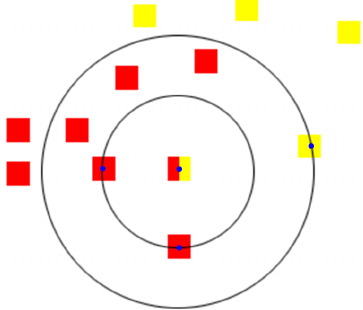
Figure 1. A sample graph of sub-pixel in a mixed pixel and its near- est pure pixel(s) of the same land cover type. There are two land cover types: yellow and red. The centre pixel, which is a mixed pixel, contains a red sub-pixel and a yellow sub-pixel. The red pix- els with blue centres are the nearest pure pixels of the red sub-pixel and the yellow pixel with blue centre is the nearest pure pixel of the yellow sub-pixel for this mixed